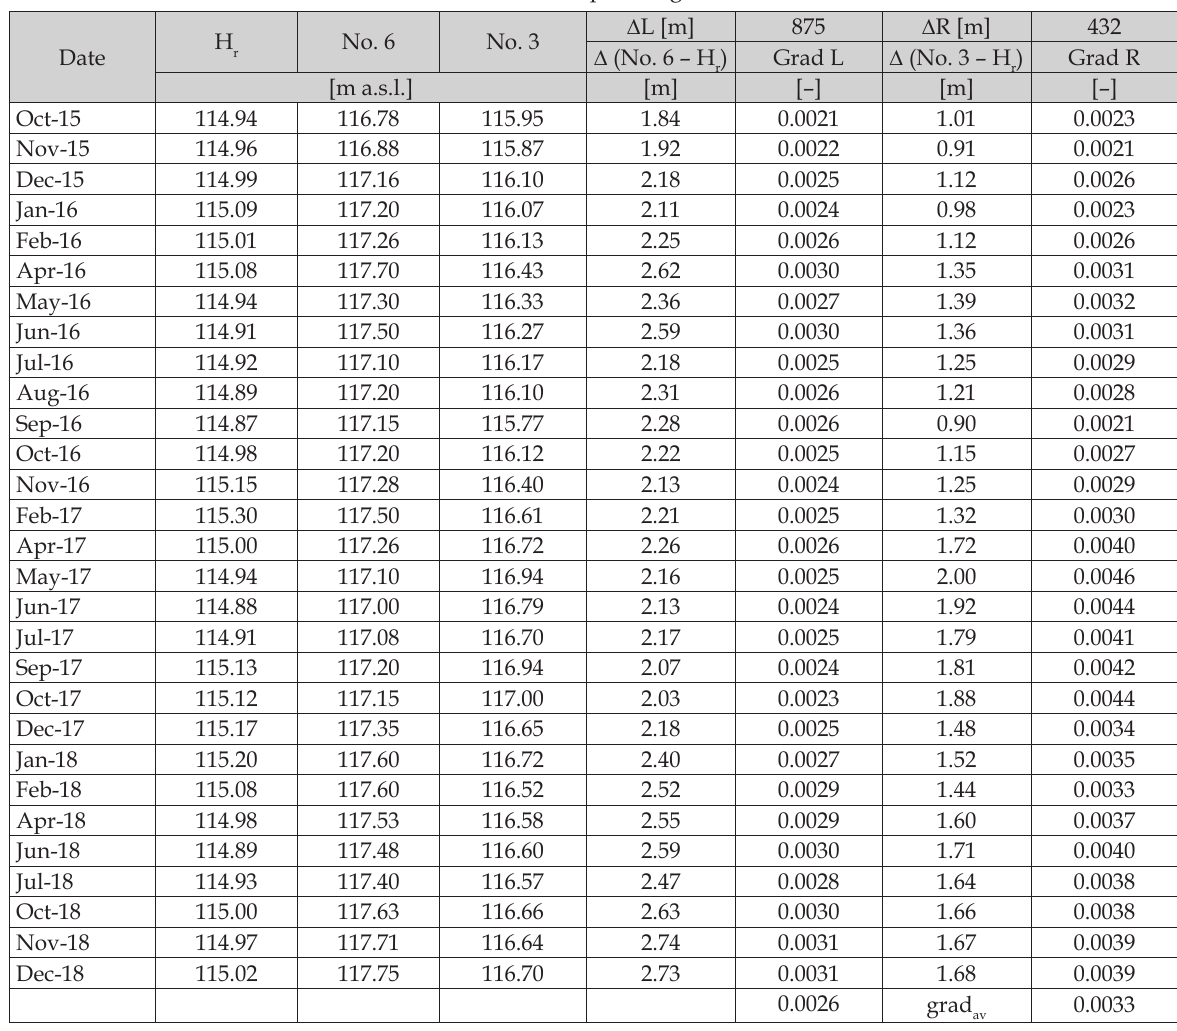
Table 2. Water levels in the riverbed, water table in observation wells and hydraulic gradients in the Moszczen- ica bottom in upwelling